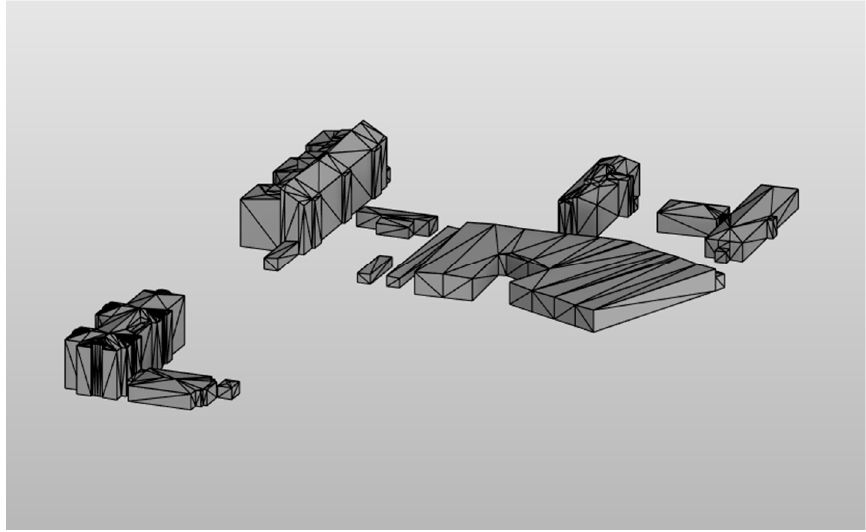
Figure 15. The dataset ExistingBuGML in CityGML Sve-Test format is imported and visualized in Revit.